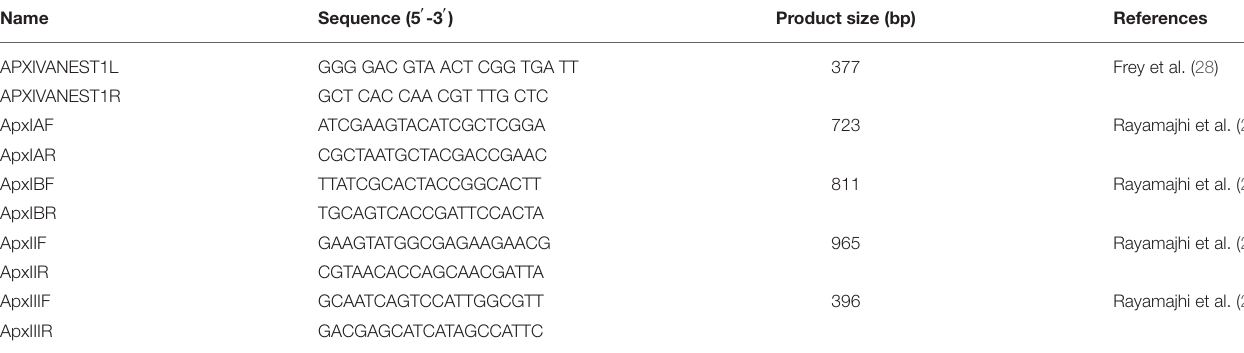
TABLE 1 | Primers sequences used in this study.